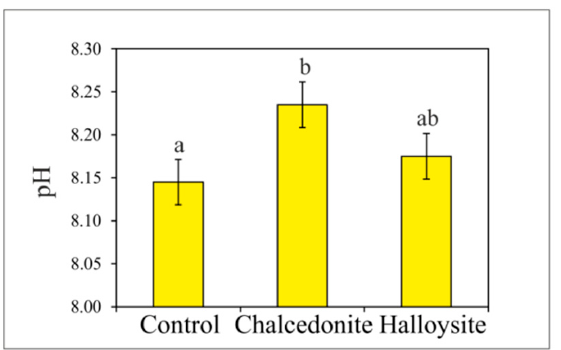
Figure 2. Soil pH after phytostabilization. Error bars ± standard error ( n = 3). Different letters denote significant differences between treatments.